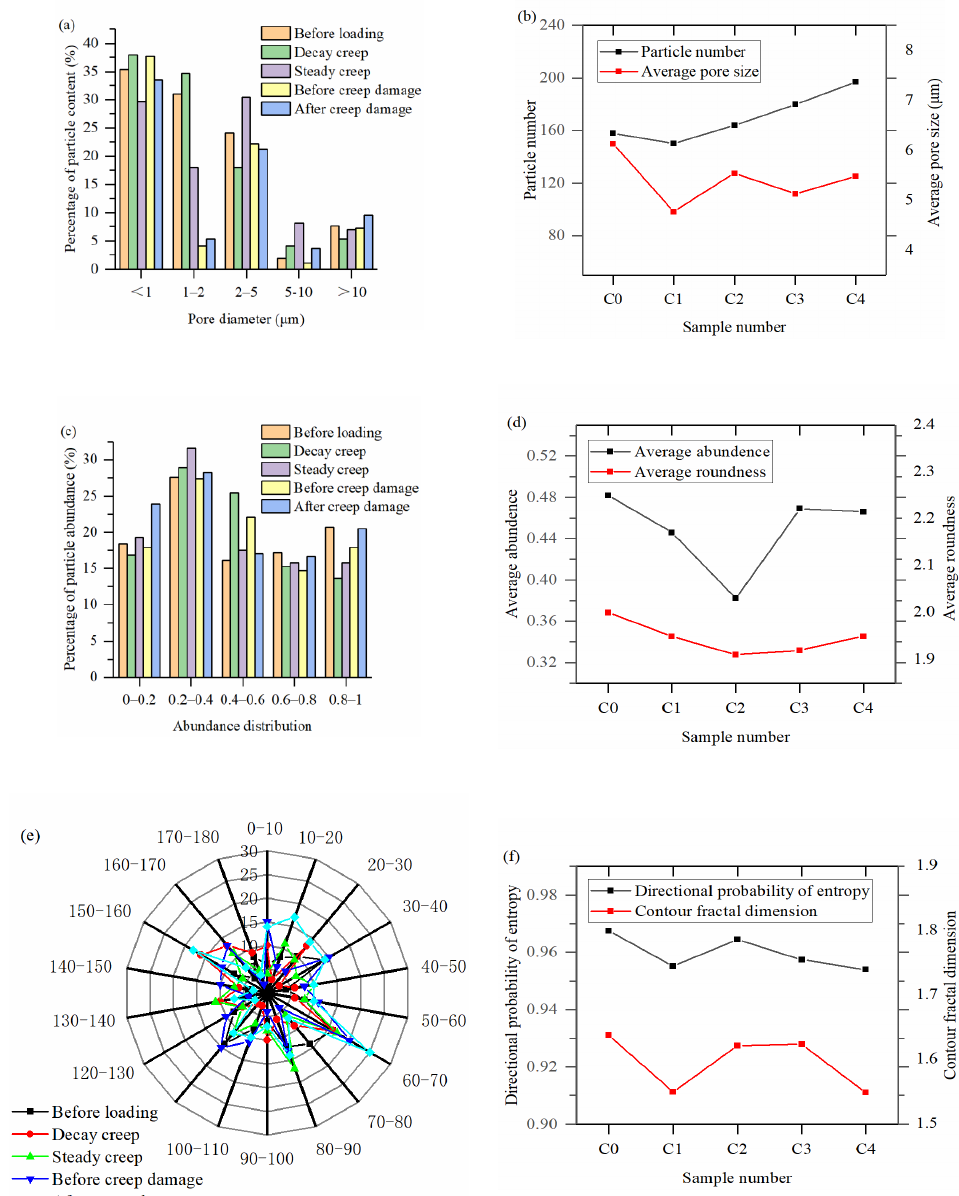
Figure 13. Quantitative analysis of remolded soil particles. ( a ) Histogram of particle content; ( b ) num- ber of particles and average particle size; ( c ) particle abundance distribution; ( d ) average particle abundance and roundness; ( e ) particle orientation probability distribution; ( f ) particle orientation probability and fractal